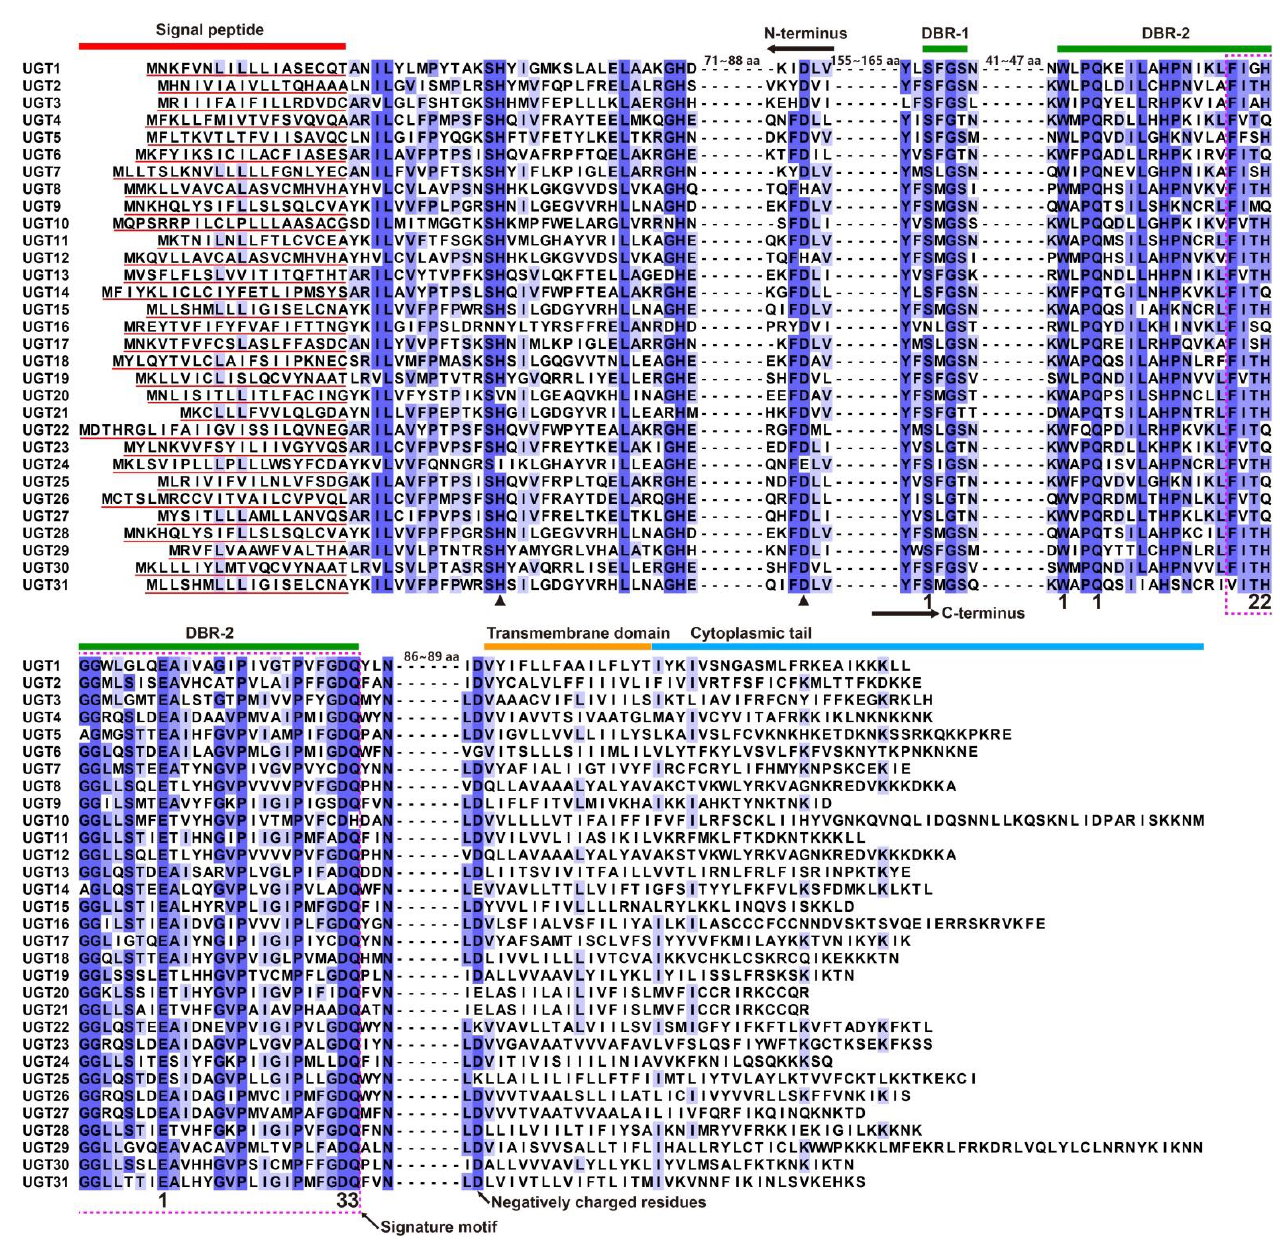
Figure 1. Multiple alignment of amino acid sequences of 31 full-length UGTs in A. yunnanensis . The signal peptide, N – terminus, C – terminus, donor binding regions (DBR – 1 and DBR – 2), a transmembrane domain, and a cytoplasmic tail are marked on the top of the alignment. Triangles represent two catalytic residues. The signature motif is indicated by a magenta dotted box. Numbers 1, 2, and 3 represent amino acids interacting with nucleotides, phosphates and glucosides, respectively.